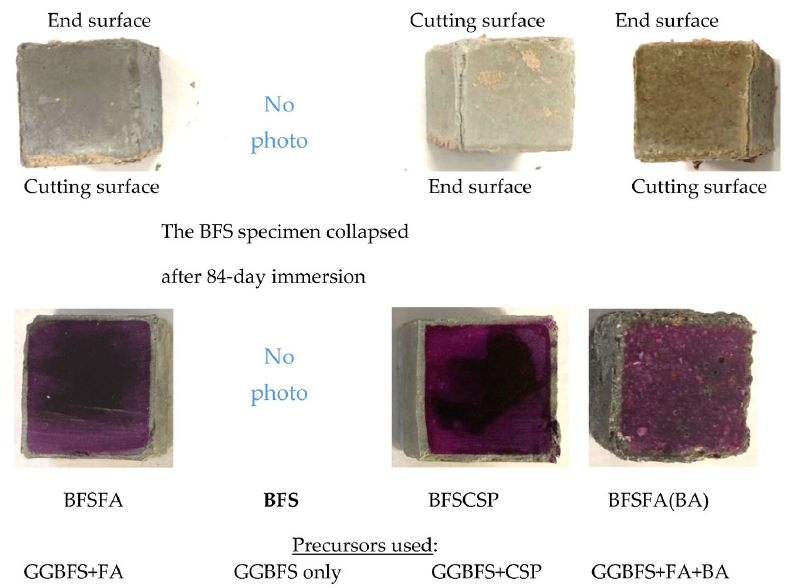
Figure 8. Appearance (upper row) and coloring (lower row) of the specimens using different precursors after 84-day sulfuric acid